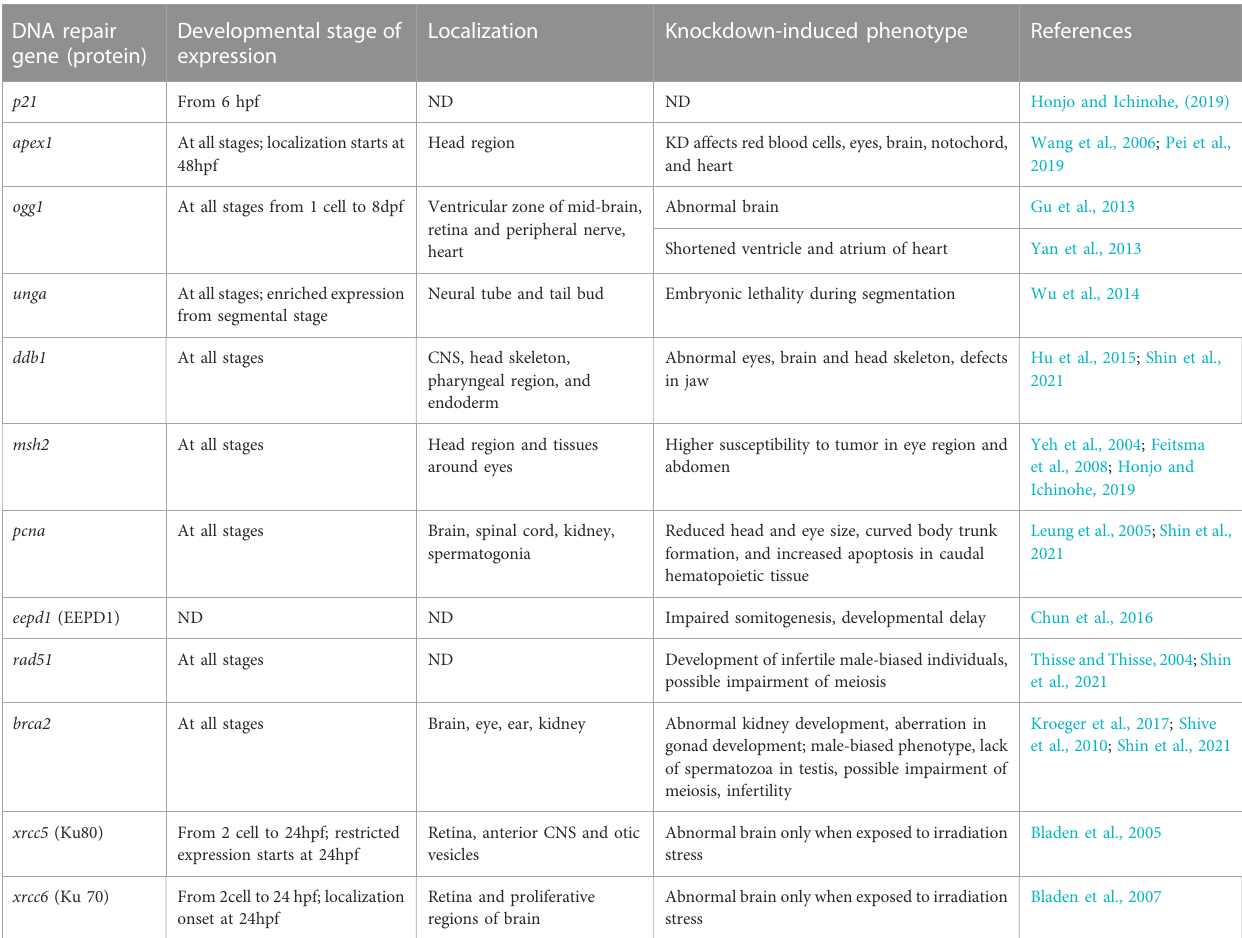
TABLE 1 Summary of the expression, localization and developmental role of zebra fi sh DNA repair genes and proteins during embryonic development. ND stands for “ not determined ” . KD stands for knockdown. DNA repair gene